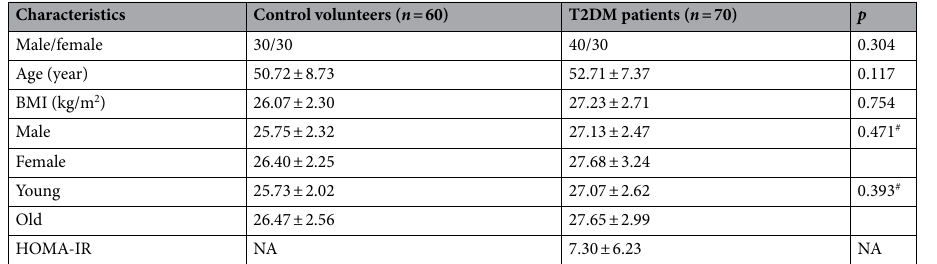
Table 1. Comparison of clinical characteristics between control volunteers without T2DM and T2DM patients ( x ± s). T2DM type 2 diabetes mellitus, BMI body mass index, HOMA-IR homeostasis model assessment of insulin resistance. # Intragroup comparison in T2DM patients.